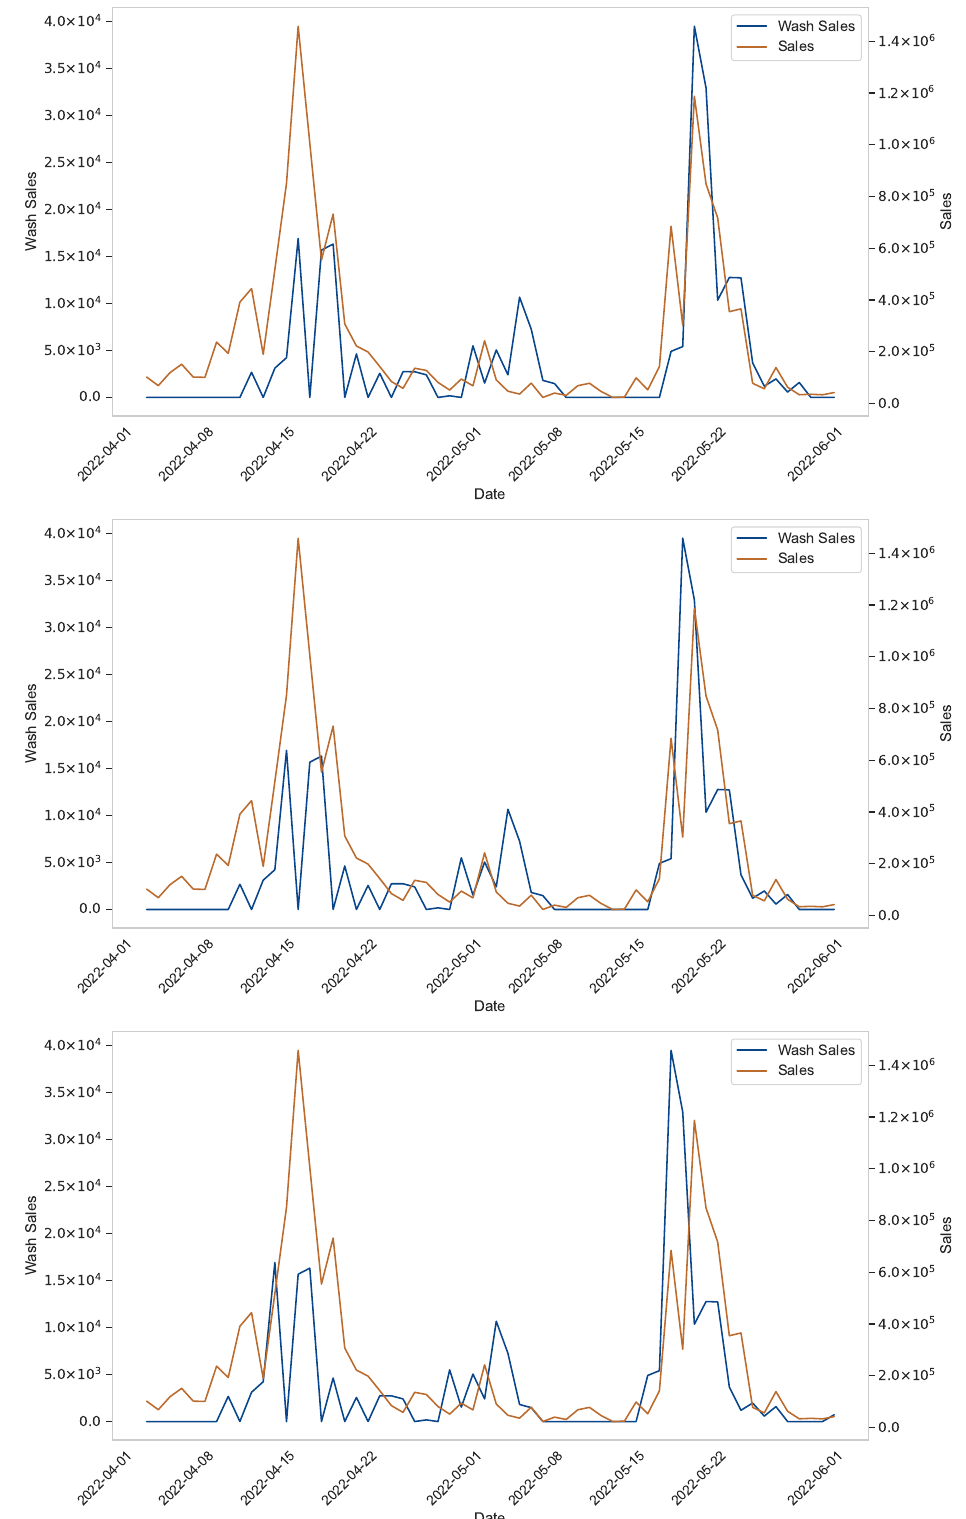
Figure 8. Cross-correlation of Wash Sales and Sales for Milady when h = 0, h = 1, and h =